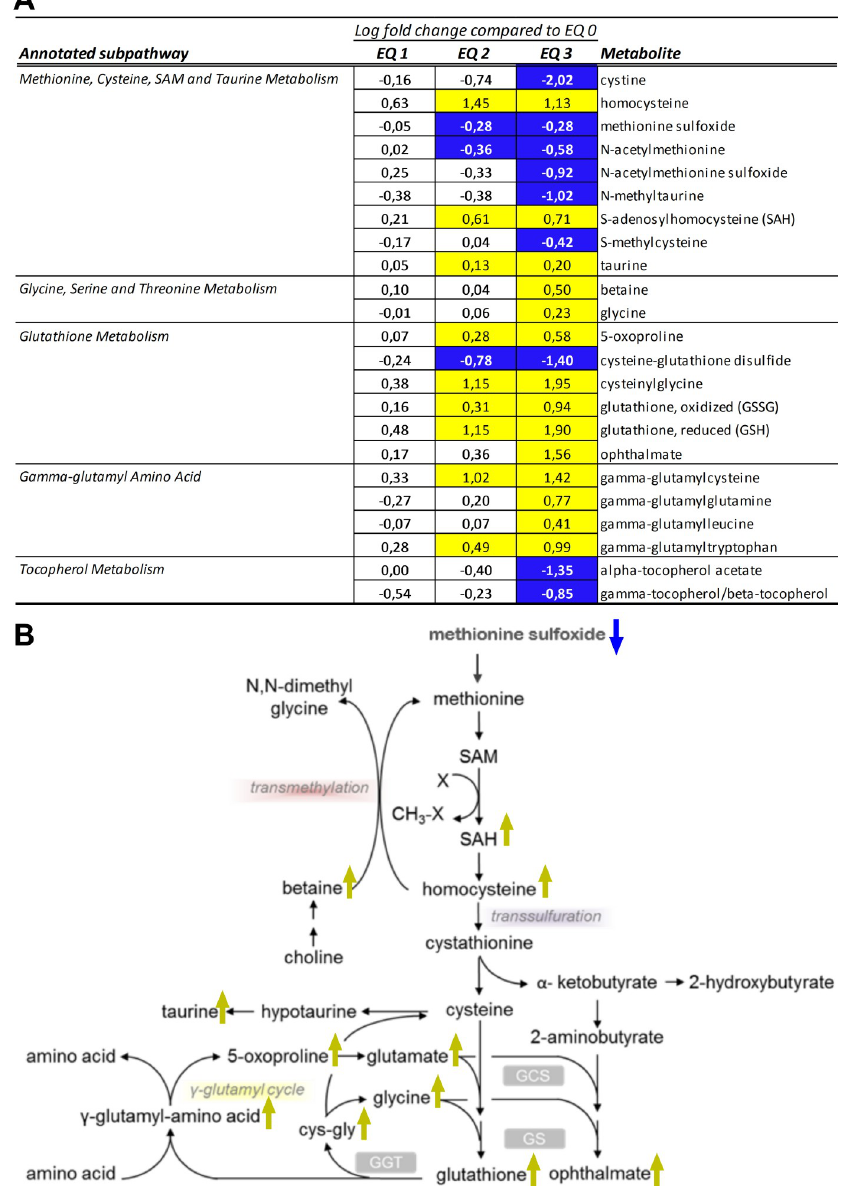
Fig 4. Changes in redox homeostasis in livers of Atlantic salmon ( Salmo salar L.) exposed to graded levels of ethoxyquin (EQ) through their diet for 90 days. (A) Metabolites displaying differential expression ( p < 0.05, ANOVA) were grouped according to subpathway annotations. Scaled intensity means were used to calculate log2 fold changes in the individual exposure groups compared to unexposed control animals (EQ 0). Significance of change was analyzed through pairwise comparisons between the individual exposure groups and the control, with colors denoting a significantly ( p < 0.05) increased (yellow) or decreased (blue) levels compared to the control. (B) Overview of selected treatment affected metabolites within the cysteine and glutathione metabolic pathways. Metabolites significantly ( p < 0.05) affected by the increasing EQ levels are denoted with yellow (increase) or blue (decrease) arrows. See S4 Table for a complete overview of individual